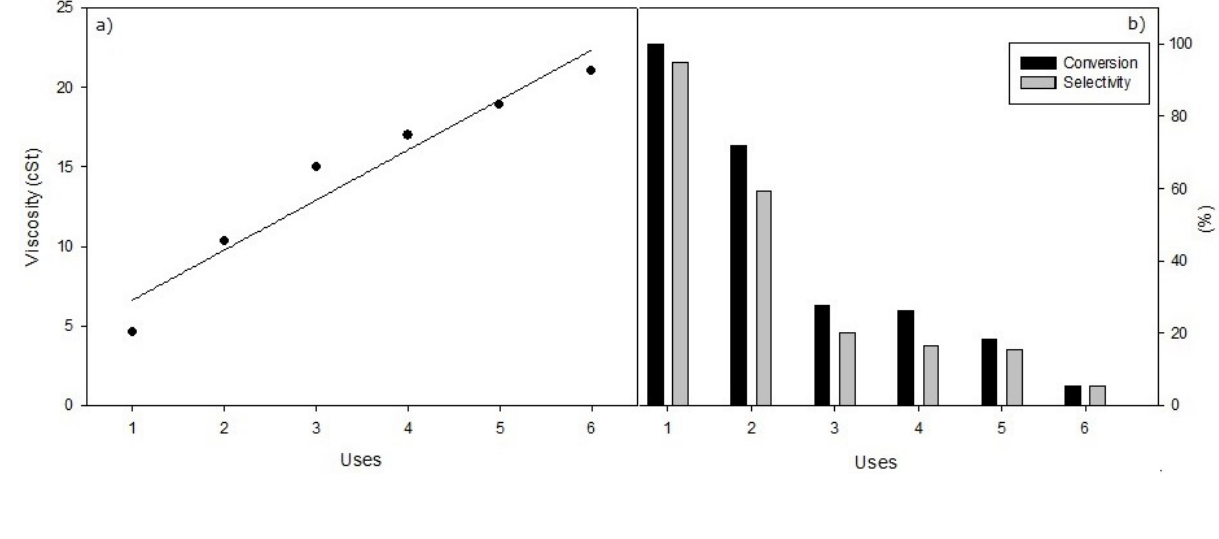
Figure 6. ( a ) Viscosity values obtained in the successive reuses of heterogeneous selective methanolysis of sunflower oil under standard conditions, with 0.8 g of KF/Al 12 mL of oil and 2.43 mL methanol. ( b ) Conversion and Selectivity values obtained with identical